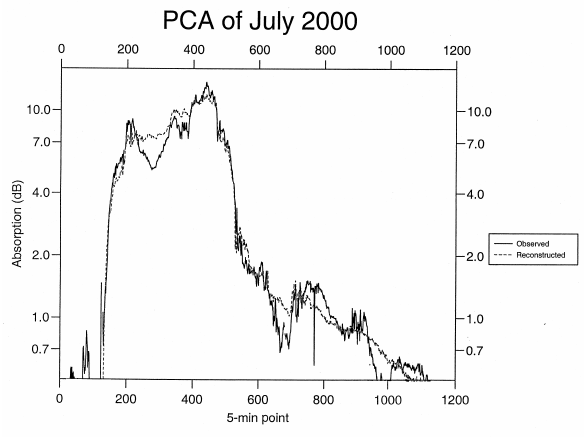
Fig. 7. Comparison between observed and reconstructed absorption during the event of July